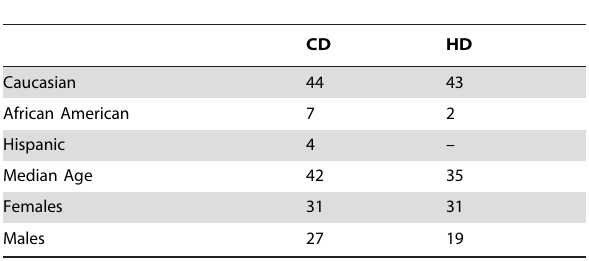
Table 1. Subject characteristics.